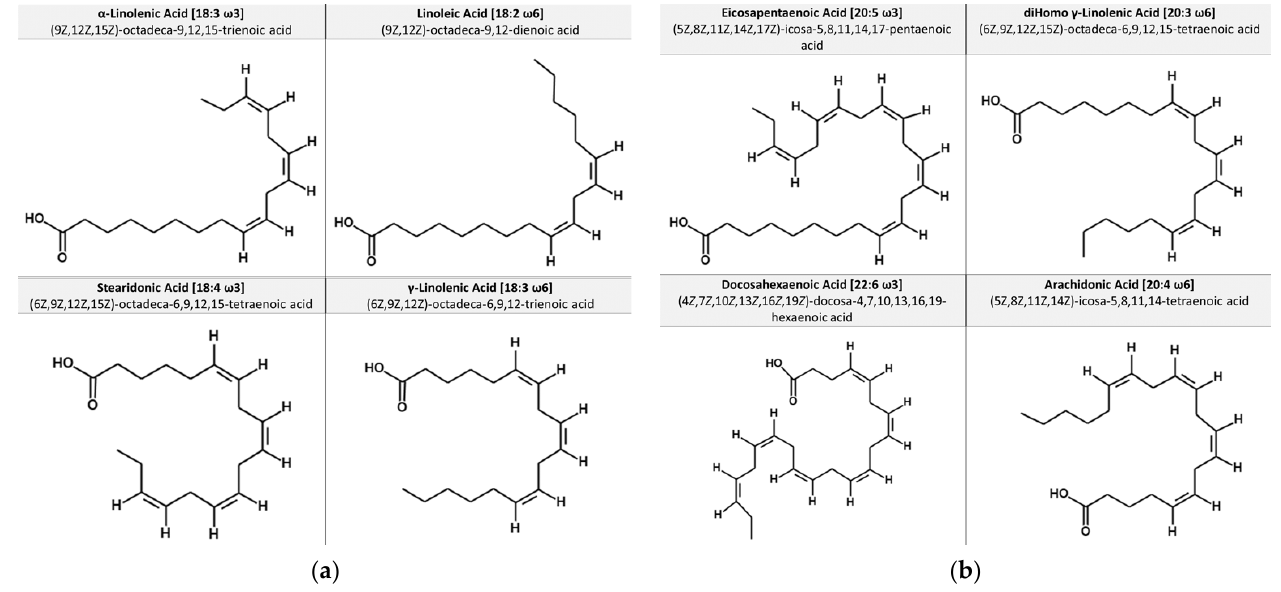
Figure 1. Chemical structures of selected essential fatty acids: ( a ) short-chain essential fatty acids; ( b ) long-chain essential fatty acids.